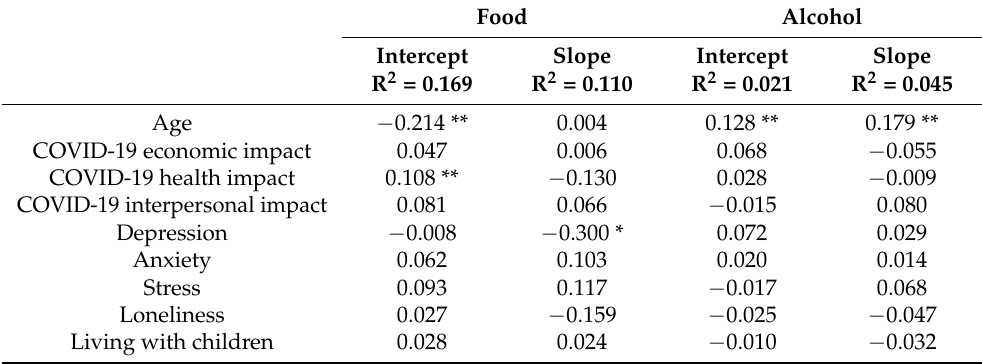
Table 3. Parameter estimates for the conditional linear model (Model c) for all participants.